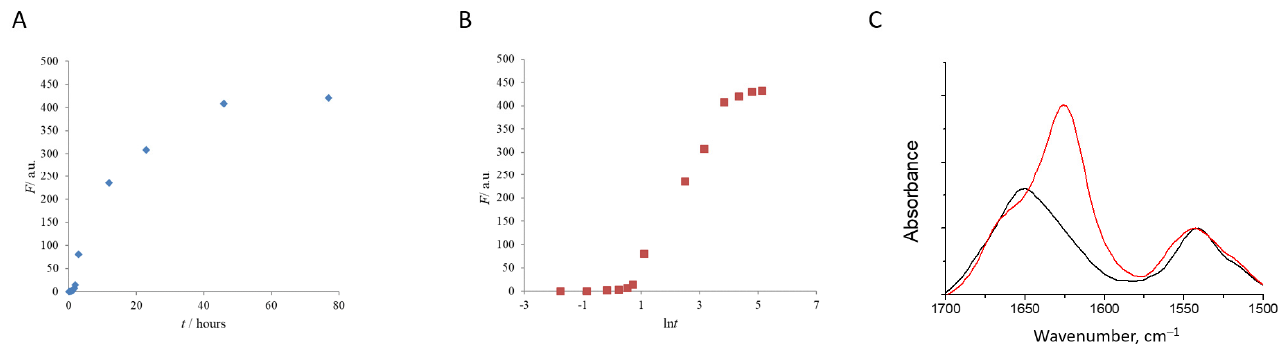
Figure 2. The kinetic curve of the HEWL fibril growth (at pH = 1.9 and T = 65 ◦ C) followed by ThT fluorescence intensity ( A , B ). Relative FTIR absorbance spectra show the conversion of native HEWL (black) into fibrils (red) ( C